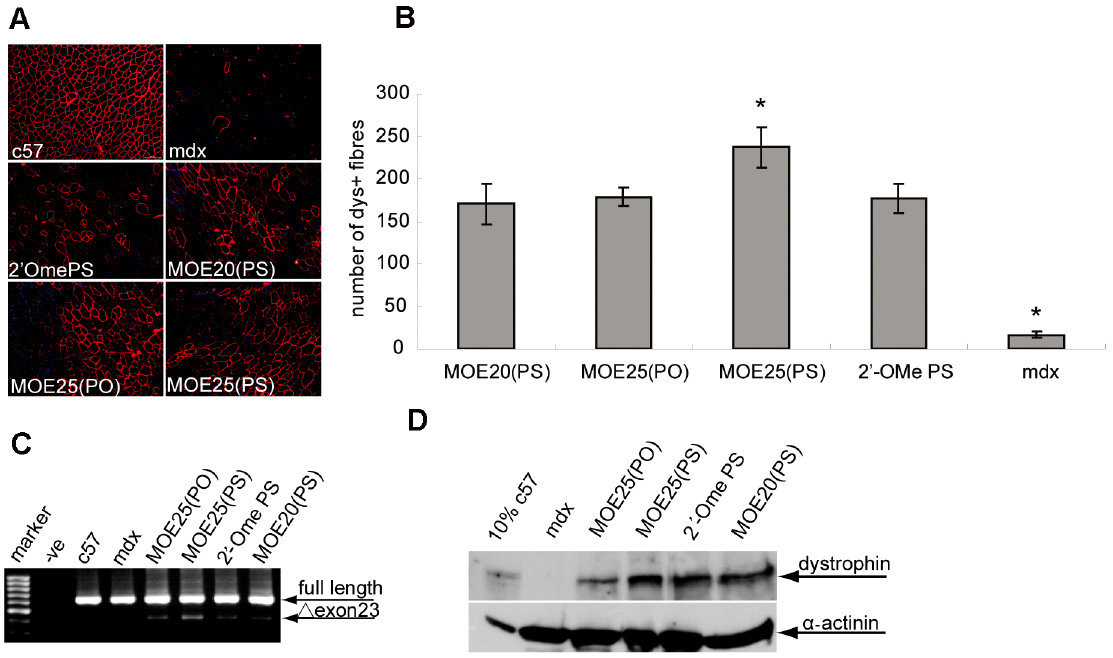
Figure 4. MOE AOs induce effective exon skipping and dystrophin restoration in mdx mice by local intramuscular injection. (A) Immunohistochemistry for dystrophin induction in TA muscles of adult mdx mice 2 weeks after one single intramuscular injection of 5 m g MOE25(PS), MOE25(PO), MOE20(PS) and 2 9 OmePS AOs (scale bar=100 m m). (B) Quantitative evaluation of total dystrophin-positive fibres in TA muscles treated with MOE and 2 9 OmePS AOs at 2 weeks after a single injection. The data shows that MOE25(PS) AOs restored significantly higher number of dystrophin-positive fibres than those of other AOs and significant difference was observed for all tested AOs compared with untreated mdx control (*p , 0.05). (C) RT-PCR to detect exon skipping efficiency at the RNA level demonstrated up to 10% exon 23 skpping in the TA muscle treated with MOE25(PS) AOs at 2 weeks after injection. This is shown by shorter exon skipped bands (indicated by D exon23 for exon 23 skipping). (D) Western blot analysis for treated TA muscles at 2 weeks after one single intramuscular injection of MOE and 2 9 OmePS AOs. Total protein was extracted from TA muscles of adult mdx mice treated with different AOs and untreated control. Fifty microgram of total protein from untreated mdx mice TA muscles and treated muscle samples was loaded. Five microgram of total protein (10%) from C57BL6 TA muscles was loaded as a normal control. No visible difference in the size of dystrophins between muscles treated with AOs and muscle from the normal C57BL6 mouse. a -actinin was used as loading